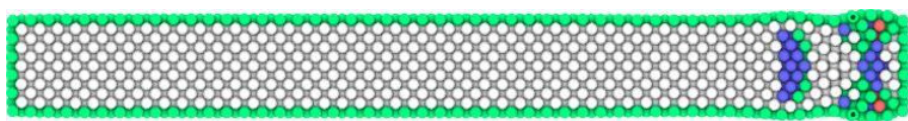
Fig. 17. Cut of the initially perfect nanorod by the plane perpendicular to the Y axis, at the time instant 2 ps after the cyclic loading start.  x 0 = 0.5 Å,  =1 THz. Green shows the surface atoms and other structureless ones; white shows the atoms forming the FCC lattice, blue shows the atoms forming the BCC lattice, and red shows the atoms forming the FCCP